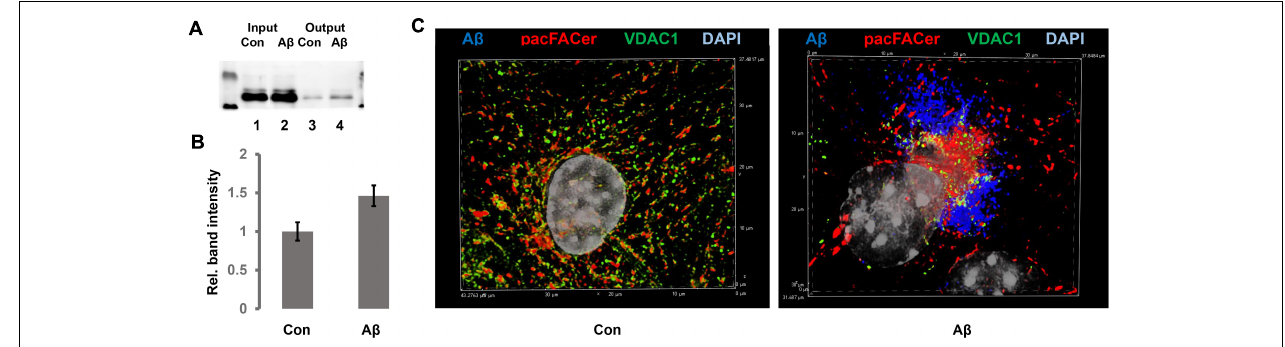
FIGURE 7 | A β enhances cross-linking of pacFACer to VDAC1. (A) N2a cells with or without pre-incubation for 24 h with 1 µ M A β 42 were treated with pacFACer and cross-linked protein isolated and separated by SDS-PAGE, followed by immunoblotting using antibody to VDAC1. Lane 1, input for pull-down of pacFACer cross-linked protein from non-treated control cells; lane 2, input for pull-down of pacFACer cross-linked protein from A β 42 -treated cells; lane 3, output from pull-down control; lane 4, output from pull-down A β . (B) Quantitation of (A) . n = 6, P < 0.005. (C) Immunocytochemistry of pacFACer cross-linked astrocytes (pseudo-colored in red) with or without A β treatment. VDAC1 was labeled with anti-VDAC1 rabbit IgG and Alexa Fluor 488 anti-rabbit IgG (pseudo-colored in green) and A β 42 was labeled with anti-A β 42 mouse IgG (clone 4G8, pseudo-colored in